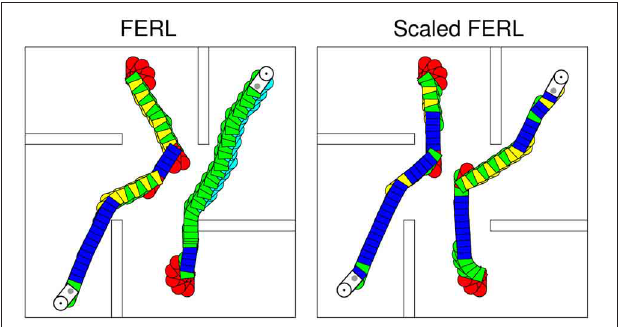
FIGURE 8 | Typical trajectories learned by FERL (left panel) and scaled FERL (right panel) for navigating to the northeast goal and the southwest goal in the experiment with two goals. The color coding indicates the selected actions: red for rotate right (action 1), green for curve right (action 2), blue for go straight (action 3), yellow for curve left (action 4), and cyan for rotate left (action 5).